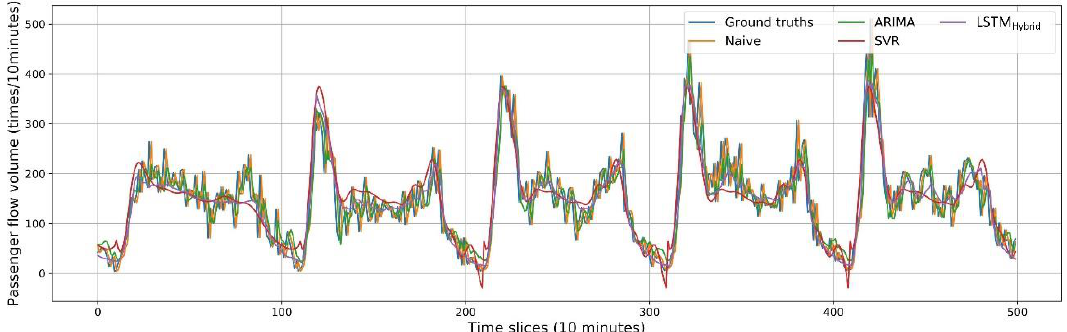
Figure 9. Prediction results and ground truths in Licun Park for Naïve, ARIMA, SVR and LSTM Hybrid model.